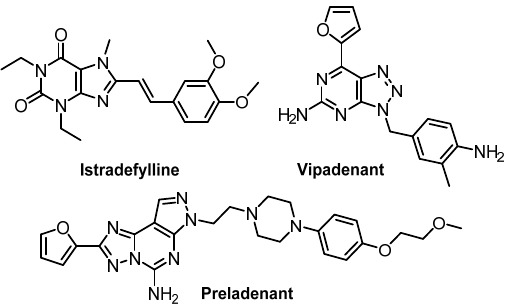
Figure 1. Representative A 2A R antagonists in clinical trials [36] .